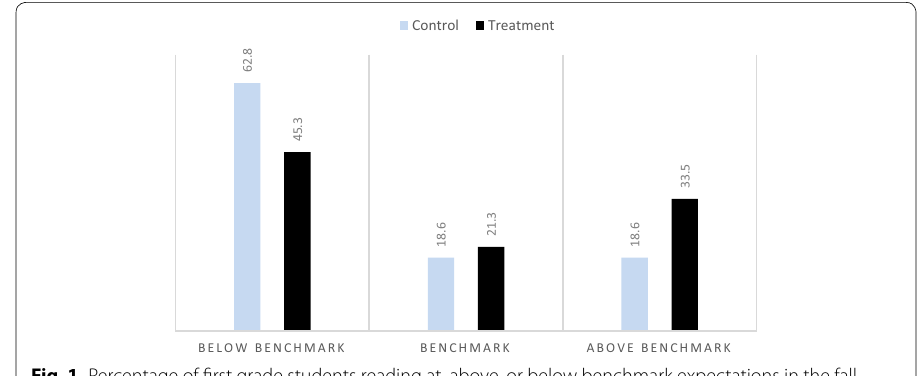
Fig. 1 Percentage of first grade students reading at, above, or below benchmark expectations in the fall depending on prior preschool attendance (treatment